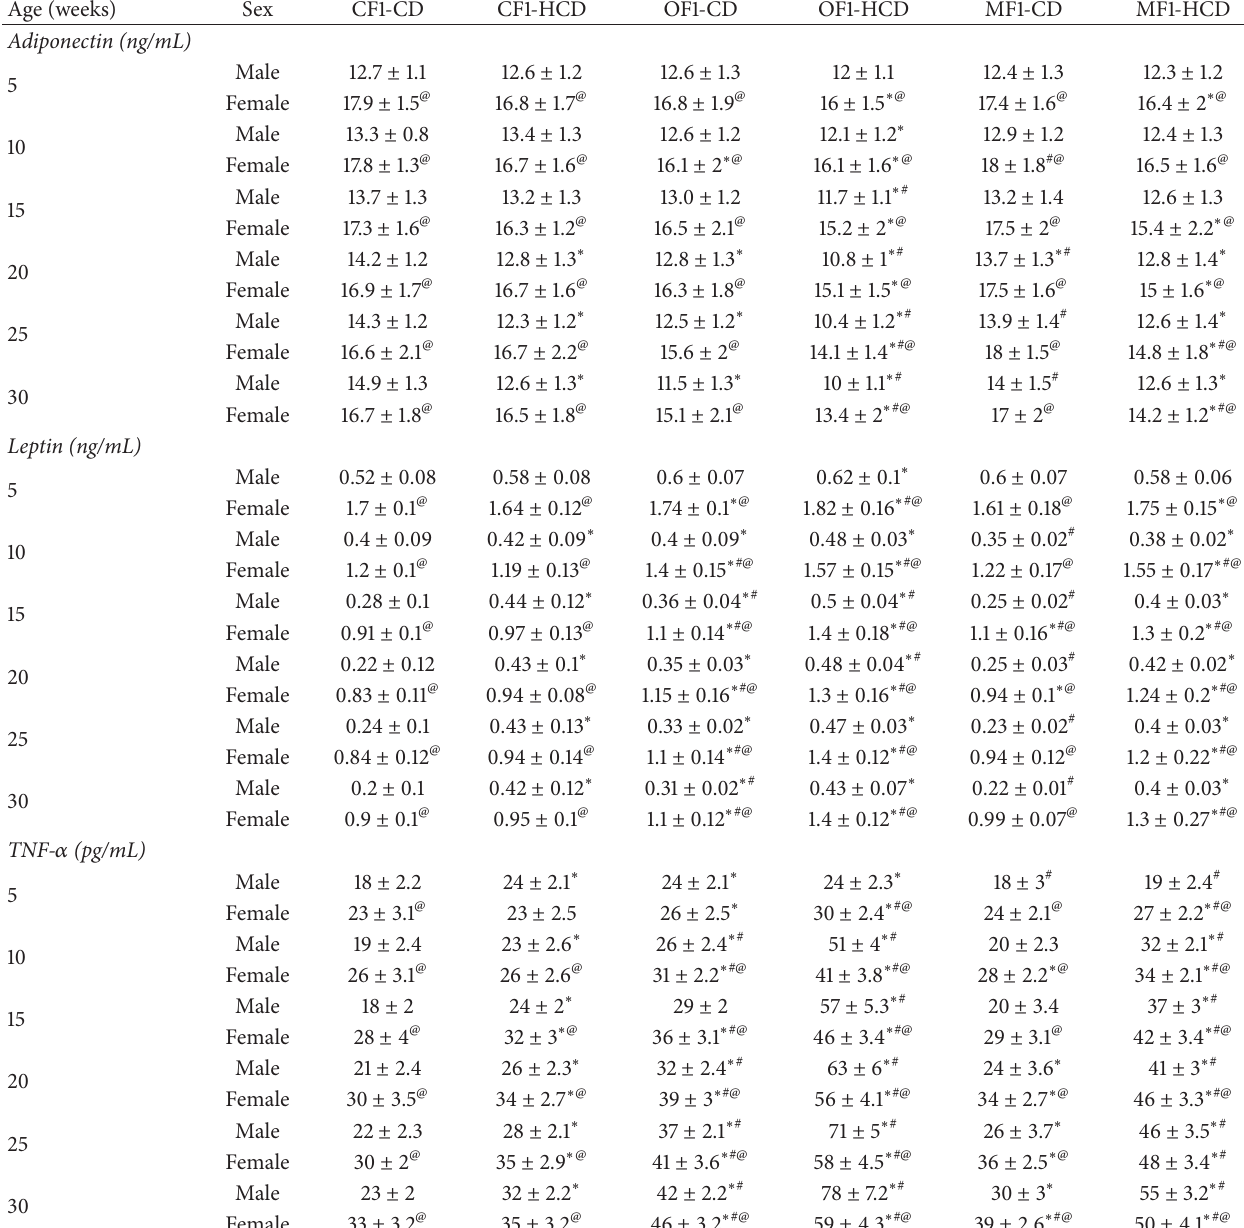
Table 3: Serum levels of cytokines in different study